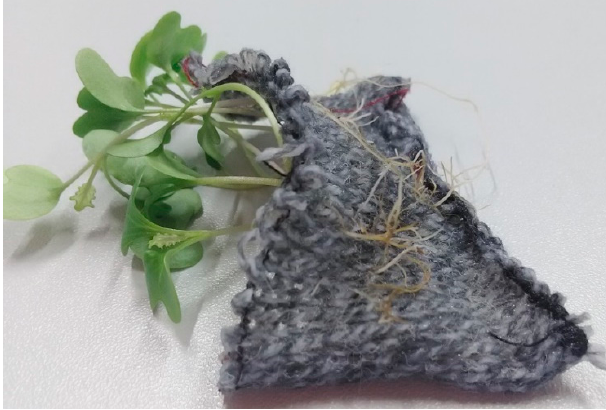
Figure 2. Roots of savoy cabbage after one month of growth.